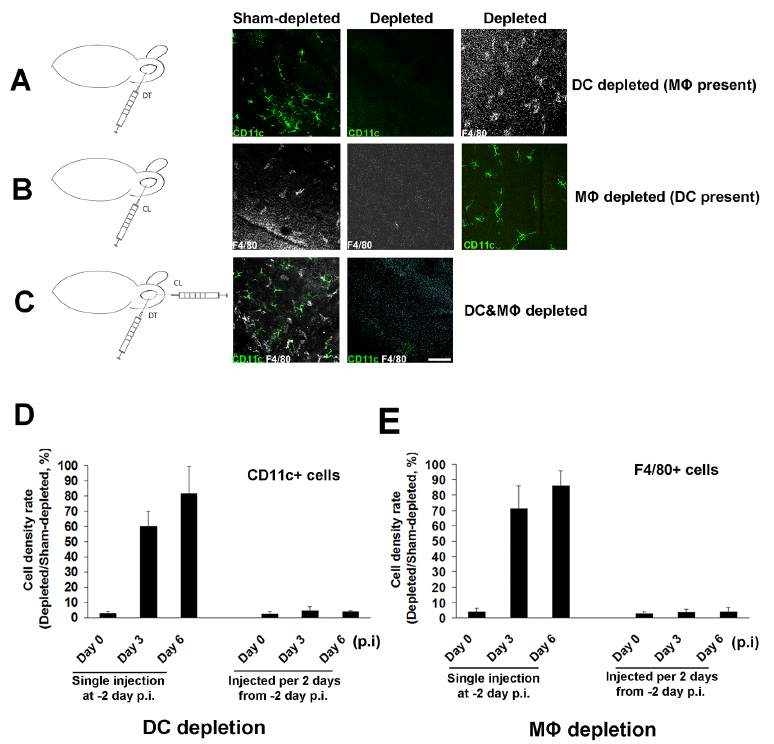
Fig 2. Corneas can be successfully single- or double-depleted of conventional dendritic cells and macrophages. Two days prior to HSV-1 infection (single injection), or every 2 days (multiple injections, started on -2 day p.i.), diphtheria toxin (DT), clodronate liposome (CL) or both, were injected subconjunctivally (s.c.) into CD11c-DTR transgenic or C57BL/6 WT mice in order to deplete corneal cDCs, M Φ s or both; C57BL/6 WT mice injected with the mixture of DT and control liposomes (without clodronate) were used as sham-depleted controls. On days 0, 3, 6 p.i., corneas (n = 5/time point) were collected for immunostaining. A: Representative micrographs showing that CD11c+ cells (cDCs) were depleted, but the F4/80+ cells (M Φ s) were present after s.c. DT injection. B: M Φ s were depleted, but cDCs were present